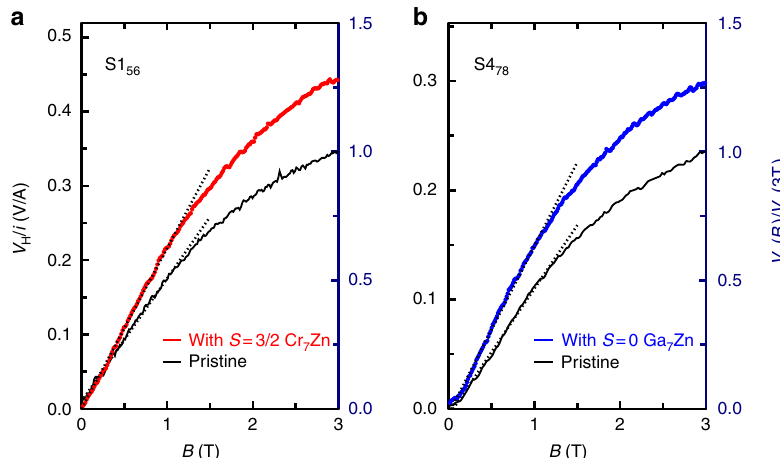
Fig. 3 The change in the low-temperature Hall effect under the in fl uence of surface modi fi cation. a , b Black curves: the Hall voltage on pristine samples; a red curve: the Hall voltage after application of magnetic Cr 7 Zn; b blue curve: Hall voltage after the application of non-magnetic Ga 7 Zn. The temperature is 1.4 K. Dashed lines are linear fi ts to the low- fi eld behaviour, from which the carrier densities are derived. The left-hand vertical axes indicate the absolute value of the Hall resistance measured; the right-hand axes indicate the Hall voltage normalised to its pristine value at 3 T, demonstrating that the relative change in Hall effect is the same for both surface modi fi cations. Thus the change in carrier density is the same for both surface modi fi cations, indicating that Cr 7 Zn and Ga 7 Zn offer equivalent electrostatic